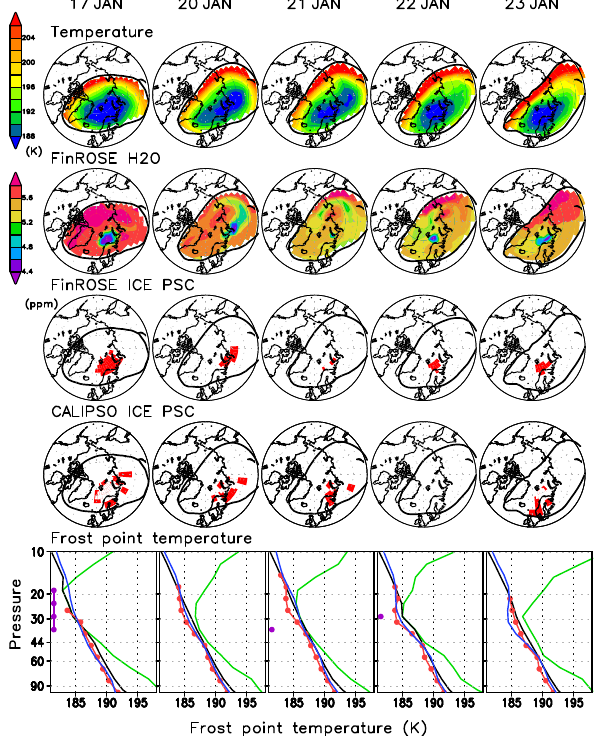
Figure 10. Upper four rows: temperature, water vapour (ppm), and ice PSC occurrence from FinROSE and ice PSC occurrence from CALIPSO during the extreme cold period of the winter of 2010. The black contour marks the border of the vortex defined as modi- fied potential vorticity (PV) > 36. All maps are at the 35hPa pres- sure level. Lowest row: ERA-Interim temperature (green) and frost point temperature from Sodankylä soundings (red dots), from MLS (blue), and from FinROSE (black). Purple dots shows the altitudes where FinROSE simulated ice